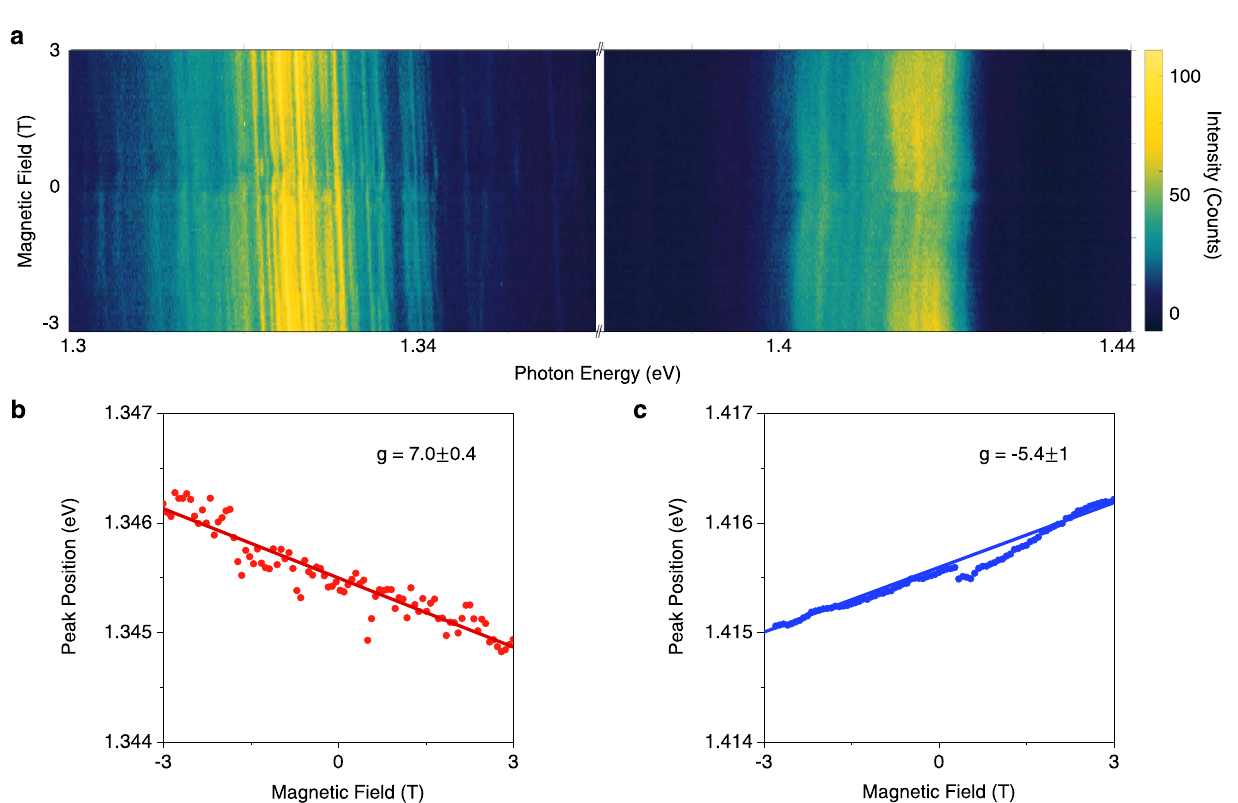
dipole moment due to the increased electron-hole separation. b PL emission as a function of doping level. The regions i, ii, and iii correspond to electron doping, neutral, and hole doping